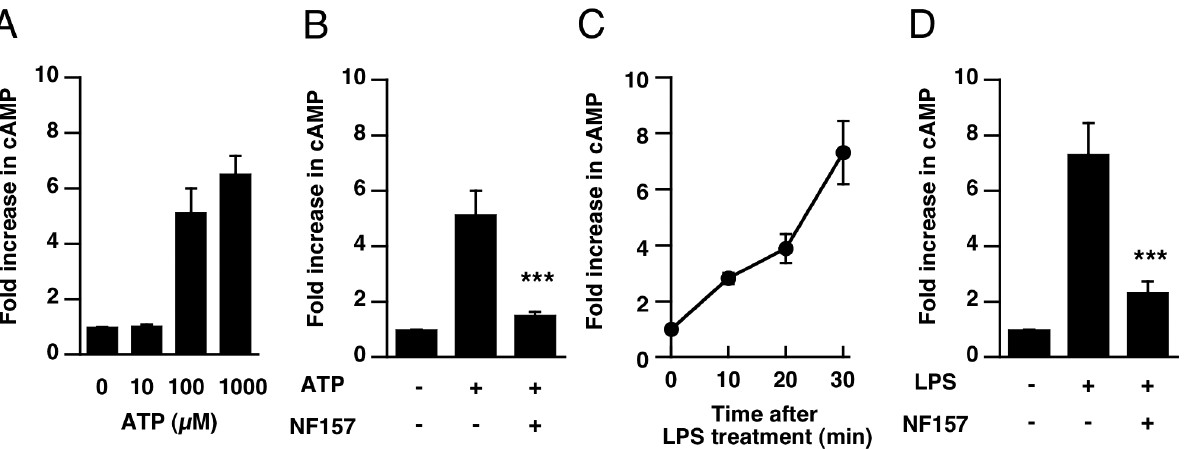
Figure 5. P2Y11 antagonist NF157 blocked ATP or LPS-induced increase of cAMP levels in THP-1 cells. (A) THP-1 cells were incubated with 10–100 m M of ATP for 10 min. (B) Cells were pre-incubated with NF157 (50 m M) for 30 min, and then incubated with 100 m M ATP for 10 min. (C) Cells were incubated with LPS (10 m g/mL) for indicated times. (D) Cells were pr)e-incubated with NF157 for 30 min, and then incubated with LPS. Intracellular cAMP level was measured as described in Materials and Methods . Data is expressed as fold increase in cAMP compared with control. Each value represents the mean 6 SE (n=4). Significant differences between the positive control group (ATP or LPS alone) and the indicated group are indicated by ***(p , 0.001).